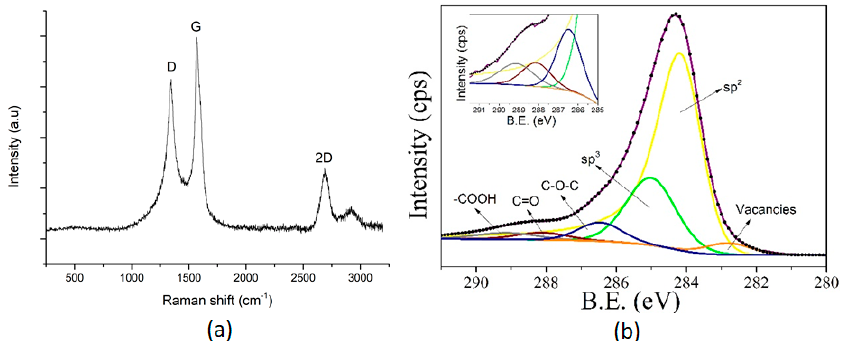
Figure 6. Raman spectra for the bare graphene ( a ). Deconvolution of the C1s core level peak for graphene ( b ). The inset shows the peaks related to oxygen functional groups.